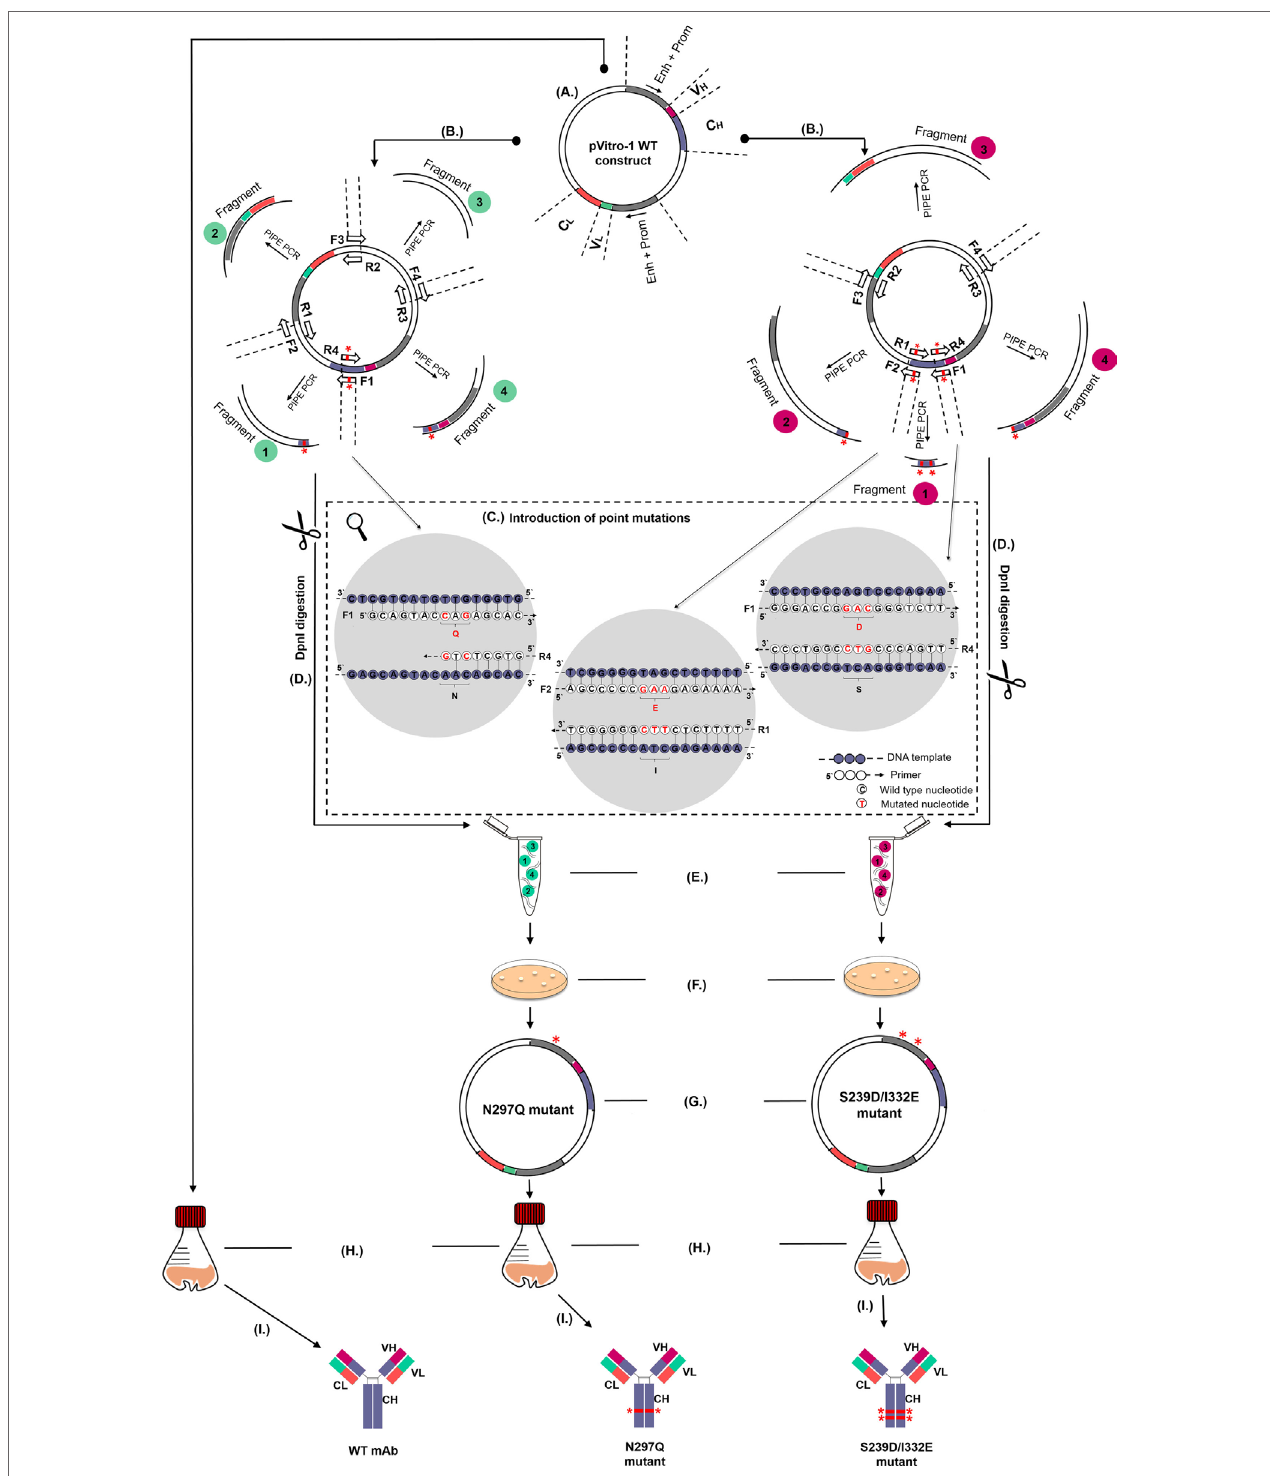
FigUre 1 | Schematic representation of the pipeline for generation and production of wild-type (WT) and Fc mutant IgG antibodies. (a) WT antibody construct in pVitro1-hygro-mcs. (b) Polymerase incomplete primer extension (PIPE) PCR linearization and mutagenesis of the WT construct to generate pVitro1 DNA fragments carrying the N297Q (left, fragments 1 and 4) or S239D/I332E (right, fragments 1, 2, and 4) mutations. Mutations indicated by “*”. (c) Introduction of mutations in WT constructs through mutagenic PIPE primers. (D) DpnI digestion. (e) Enzyme-independent assembly of the linear pVitro1 fragments. (F) Bacterial transformation of the assembled constructs. (g) Confirmation of the insertion of desired mutations. (h,i) Recombinant expression in Expi293F cells (h) and purification (i) of antibody WT and mutant